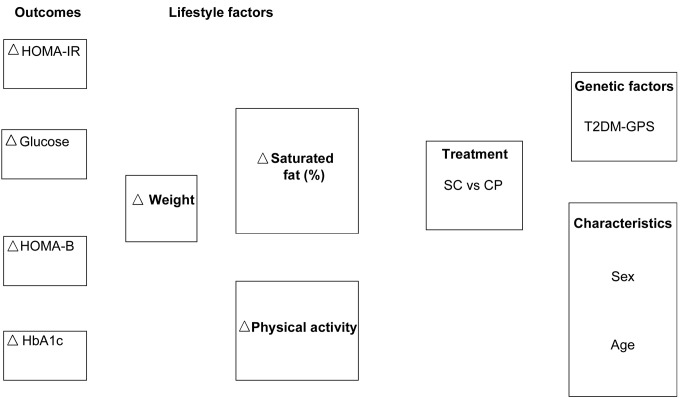
Variables to explore the paths between lifestyle and genetic factors on change in outcomes.Initial ordering of variables including baseline characteristics, genetic factors, treatment, change in lifestyle factors (weight, saturated fat and physical activity) and the change in outcomes. The variables depicted in the figure are ordered so that those variables on the left hand side can be regarded as response variables to those on the right hand side. Some variables play a similar role in the path of associations but they are not related with each other. These are presented in stacked boxes (e.g. dietary saturated fat and physical activity).